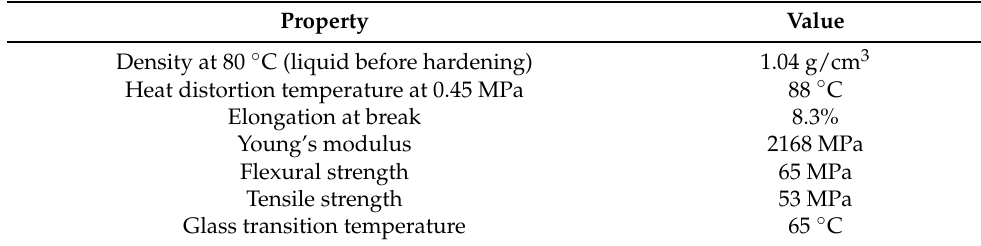
Table 1. Properties of the selected polymeric material—M3 X.